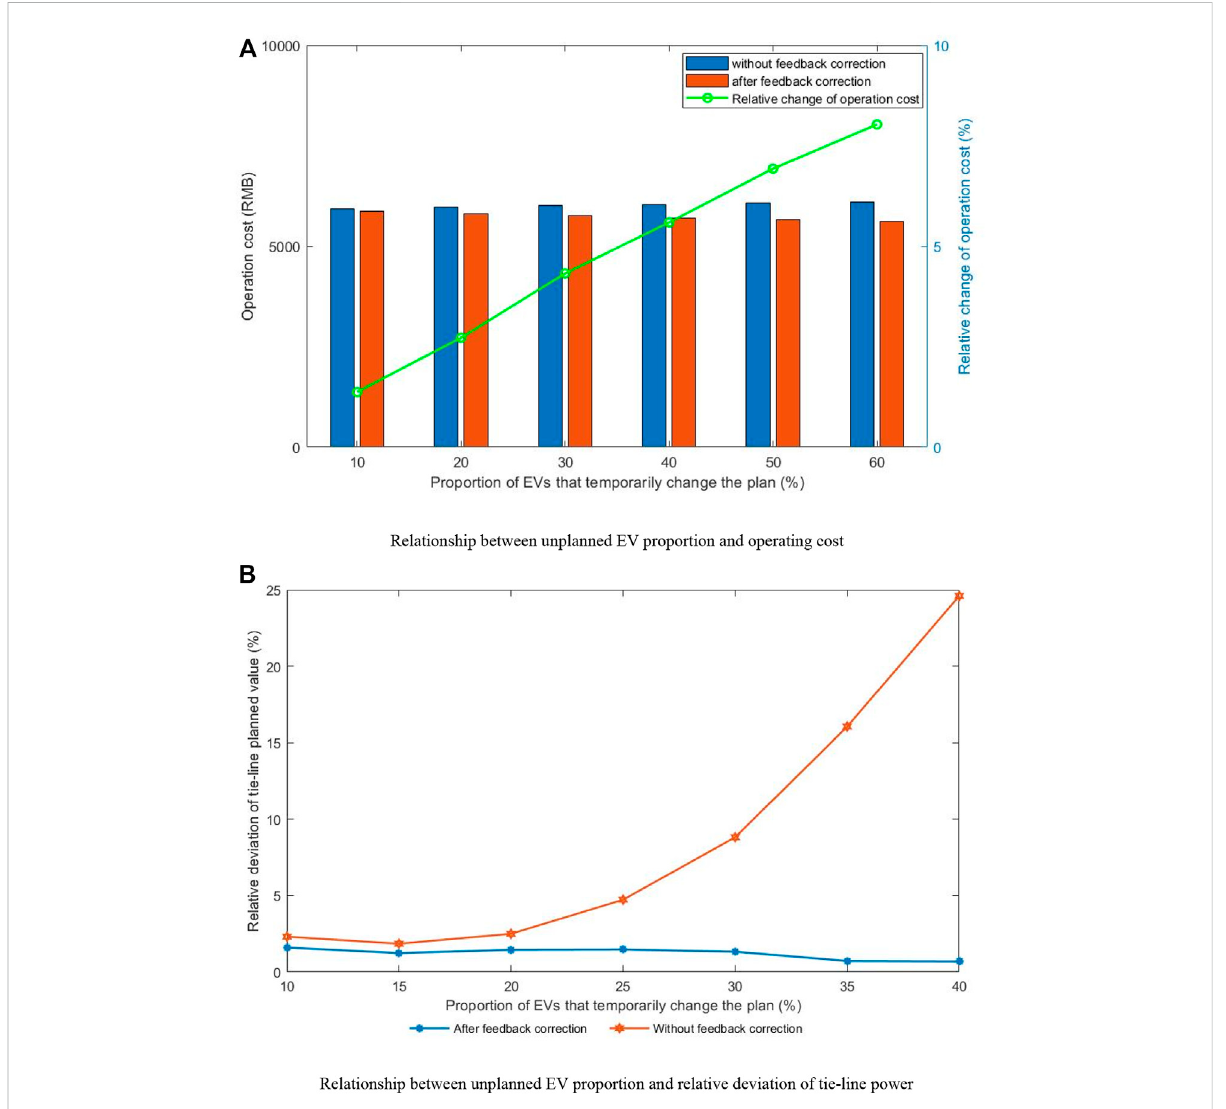
FIGURE 11 In fl uence of unplanned EV ratio on Scheduling Results. (A) Relationship between unplanned EV proportion and operating cost. (B) Relationship between unplanned EV proportion and relative deviation of tie-line